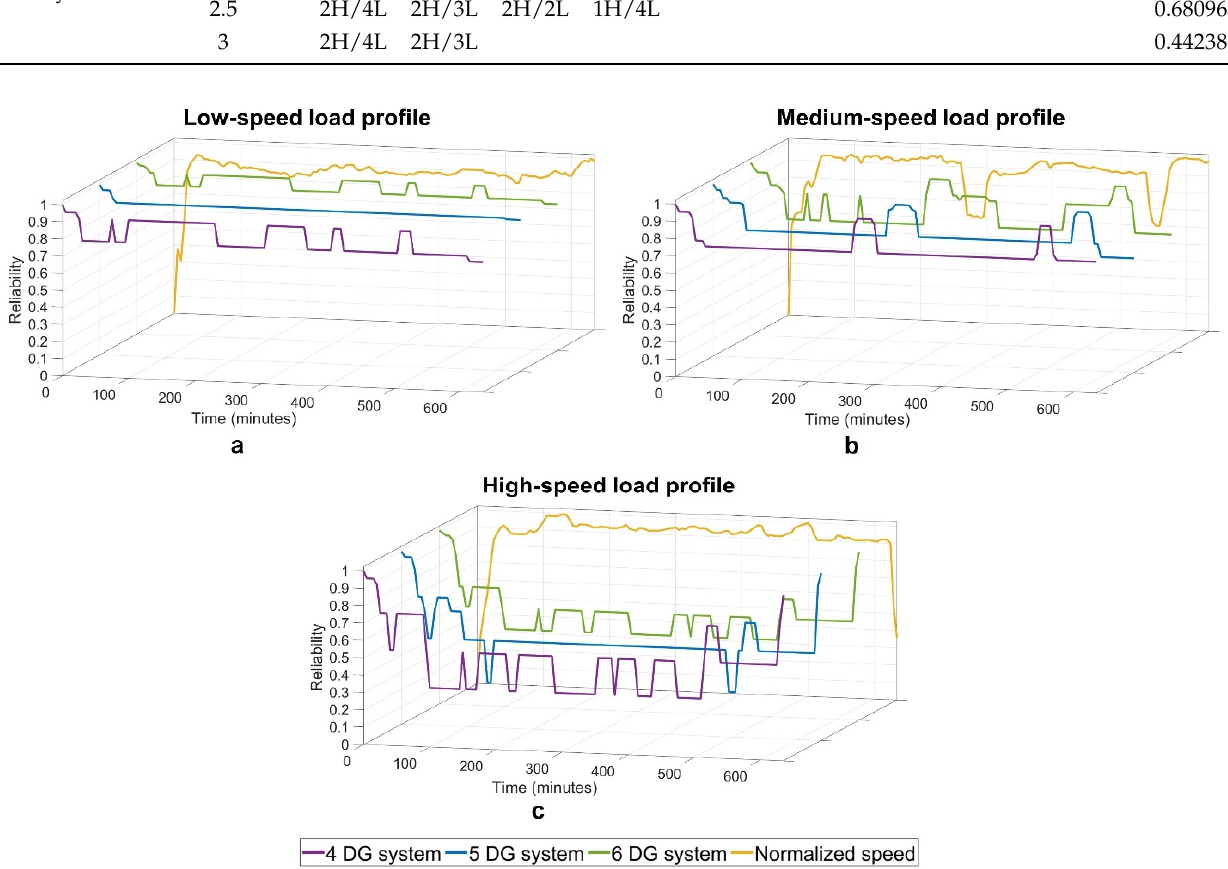
Figure 16. Reliability profiles of configurations for: ( a ) low-speed profile ( b ) medium-speed profile ( c ) high-speed profile.